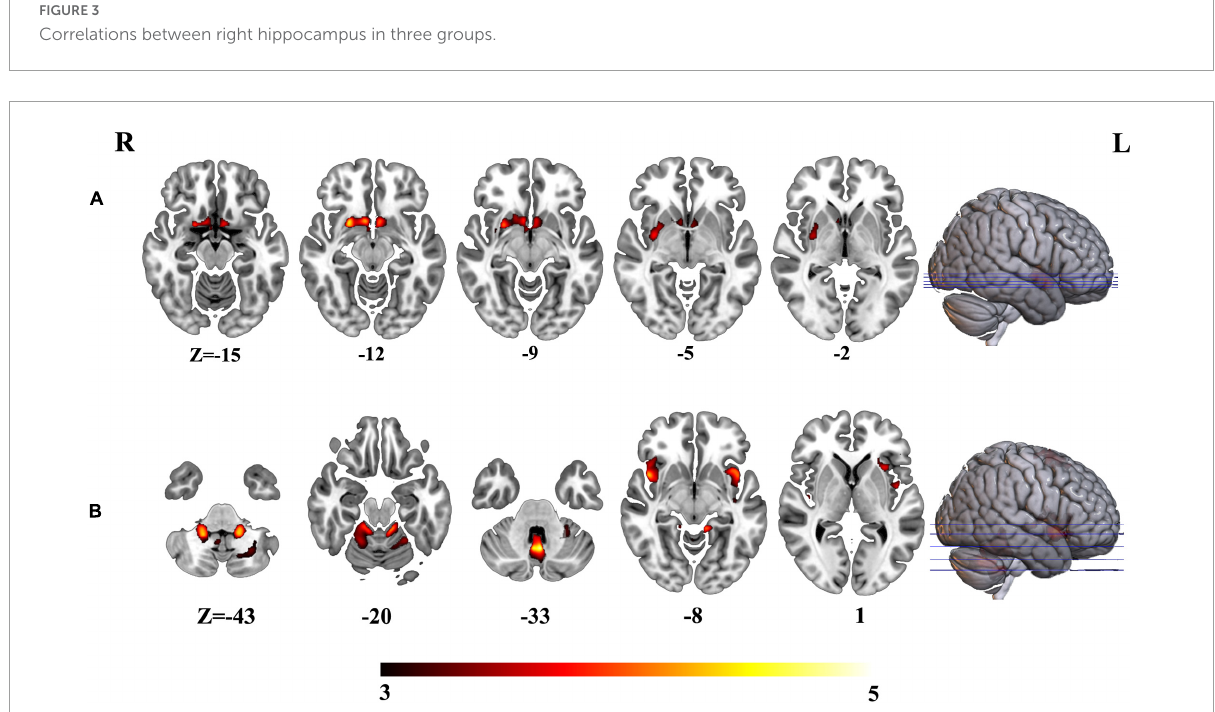
FIGURE4 (A) Altered structural covariance of left hippocampus in AD compared with HCs. (B) Altered structural covariance of left hippocampus in AD compared with